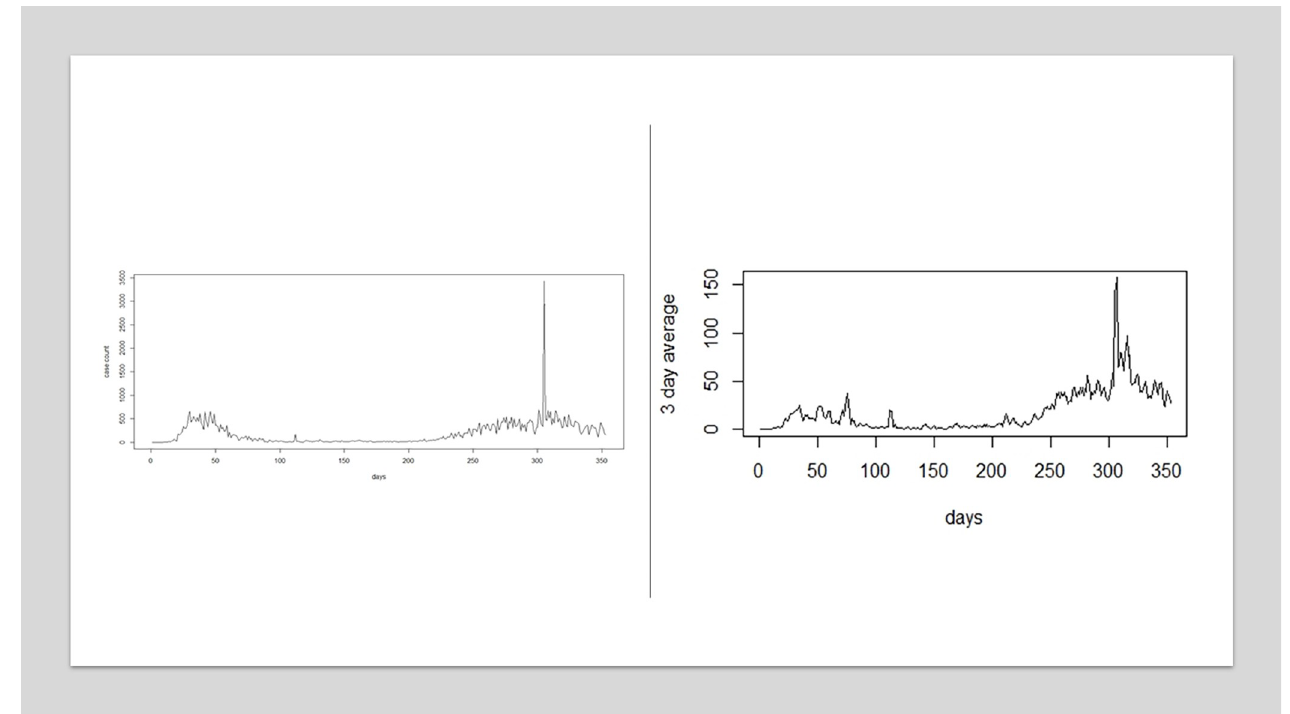
Fig 9. Hunterdon county case count (left) and 3D average (right): March 6th 2020 to February 21 st 2021.